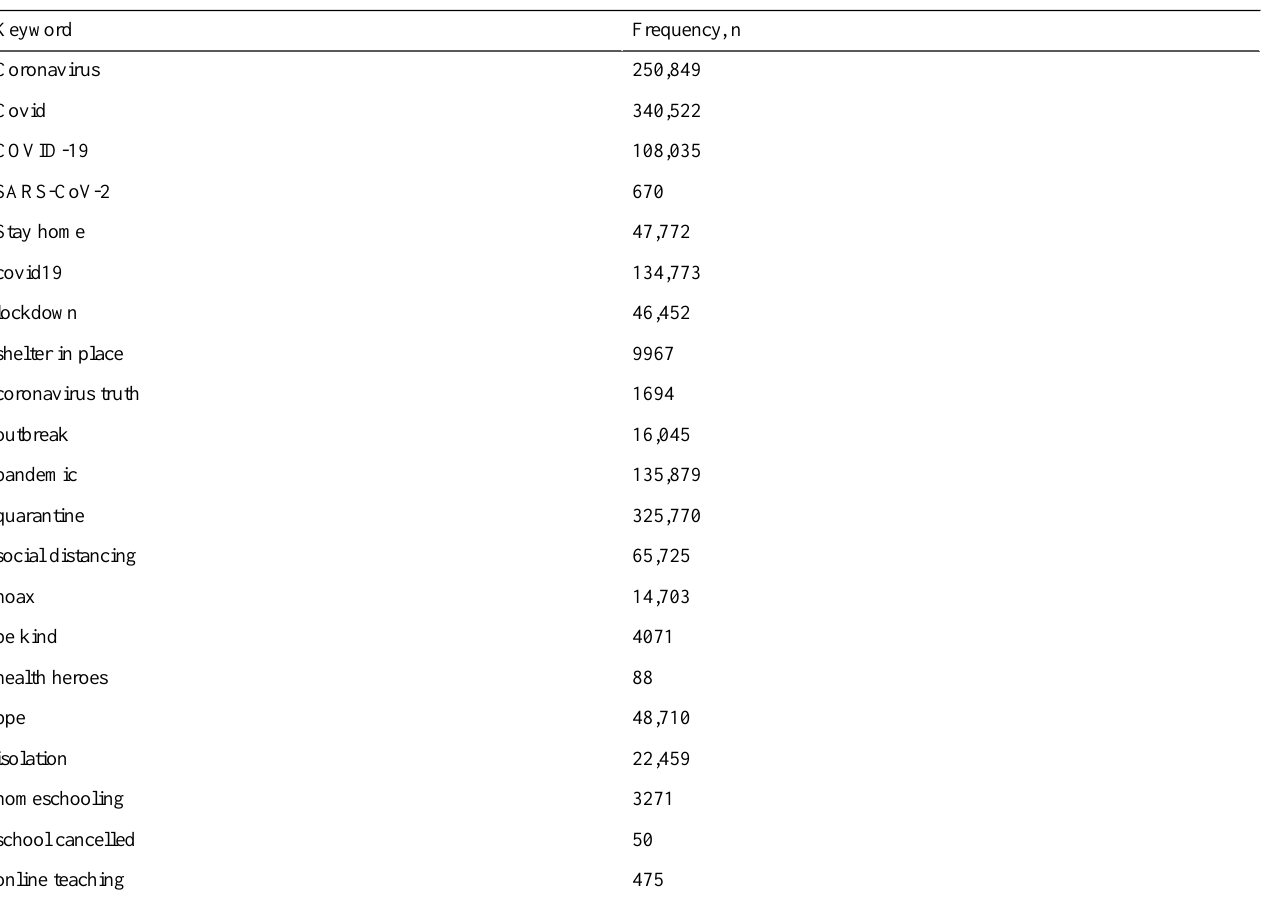
Table 1. Keywords for Twitter post search